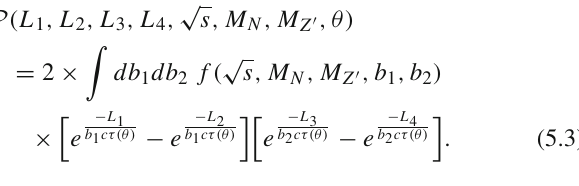
Fig. 5 Distribution of the decay length of N in the lab frame at the HL-LHC and at FCC-hh for the considered masses of Z (cid:2) and N